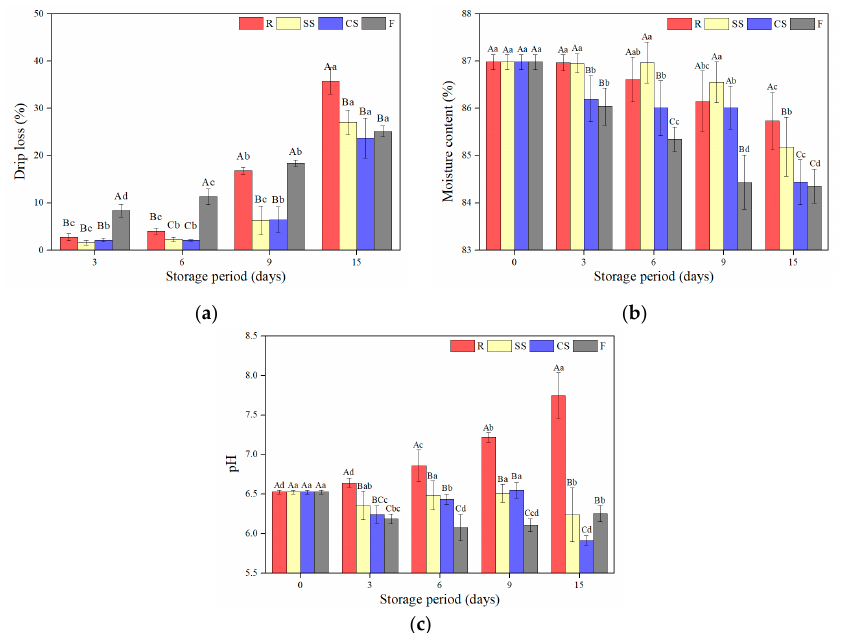
Figure 2. Changes in ( a ) drip loss, ( b ) moisture content, and ( c ) pH of raw laver ( Pyropia yenzoensis ) depending on various storage methods and periods. R, refrigeration; SS, supercooling by stepwise cooling algorithm; CS, constant temperature supercooling; F, freezing. A–D Means with different let- ters within the same storage period are significantly different ( p < 0.05). a–d Means with different letters within the same storage temperature are significantly different ( p < 0.05).